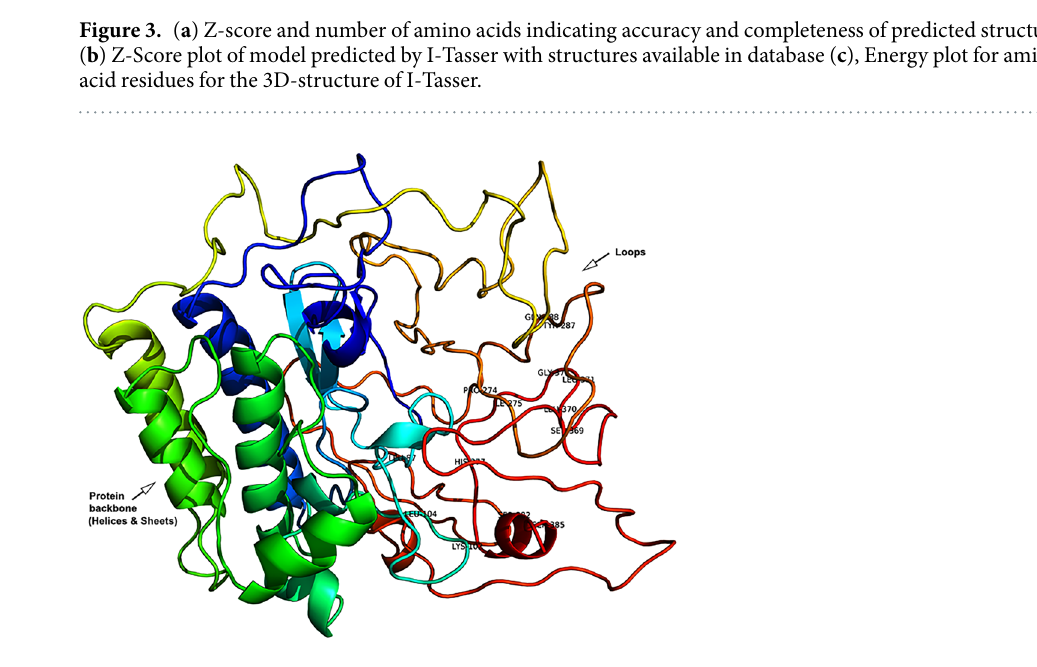
Figure 4. 3D-Structure of Ror1 protein and its actives